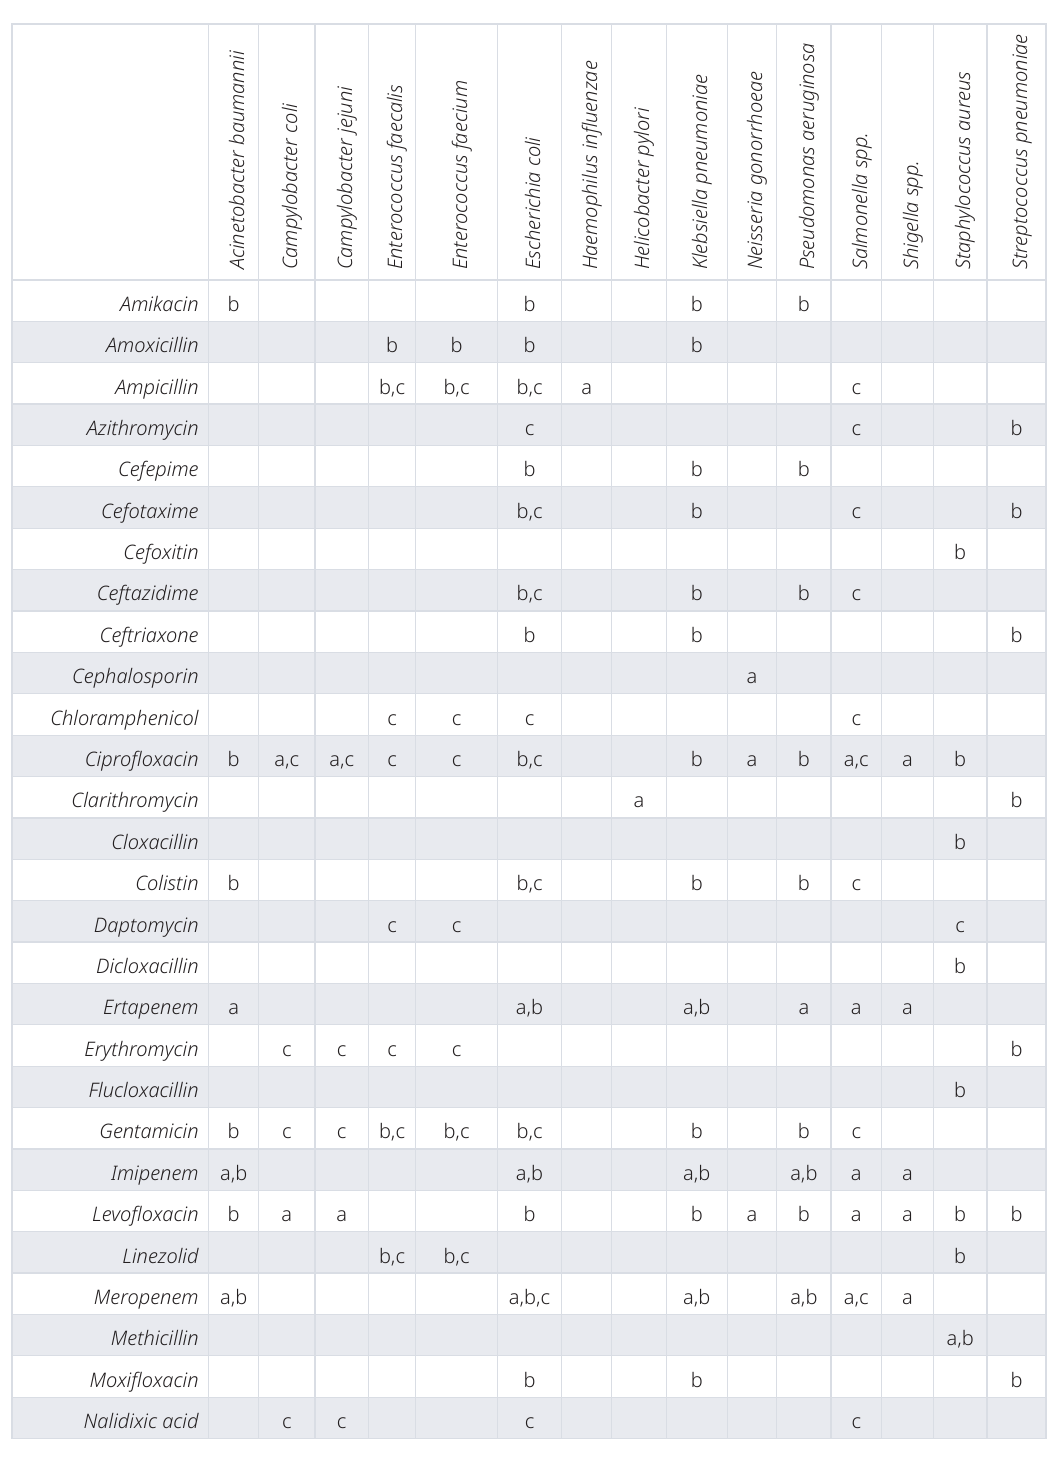
Table 2. Summary of the bacterial species and antibiotics resistances mentioned in the three lists discussed in the text. a: WHO’s list of antibiotic-resistant “priority pathogens”. b: EARS-Net reporting protocol for 2018. c: Commission Implementing Decision